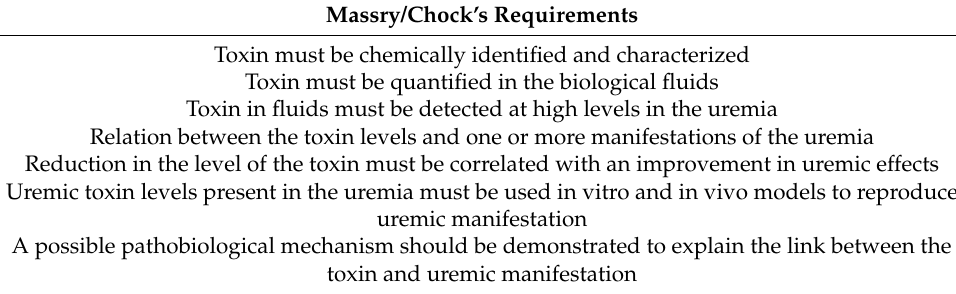
Table 1. Massry/Chock’s requirements for uremic toxin classification.